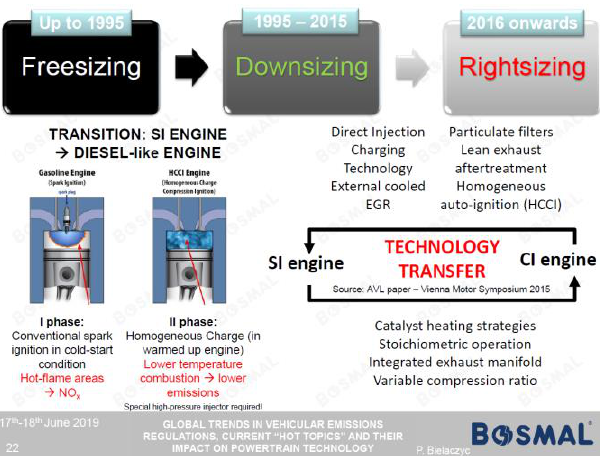
Fig. 1. Overview of engine technology trends, including the ongoing gradual convergence of SI and CI engines